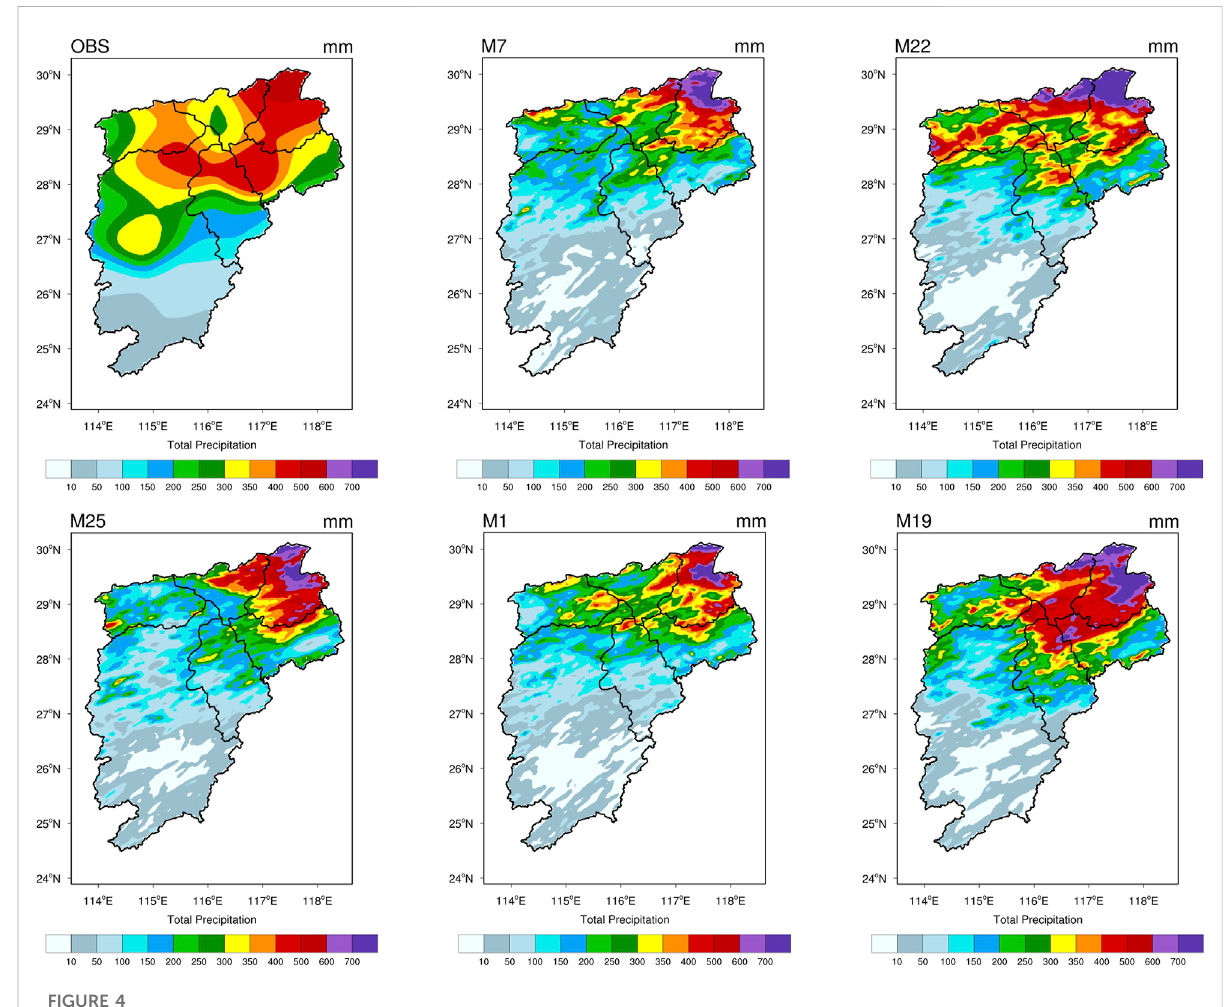
FIGURE 4 Spatial distribution of TCP for OBS and WRF combination